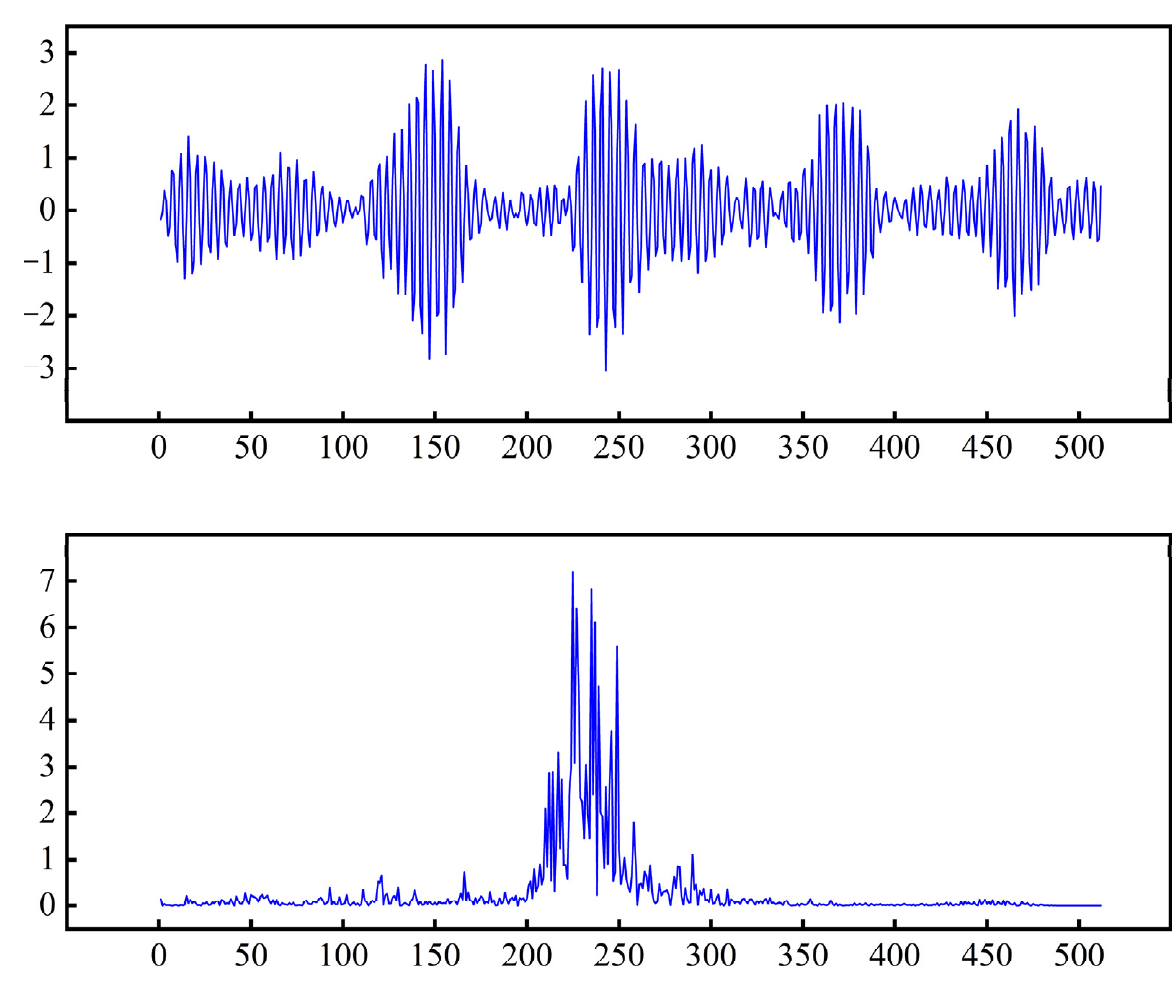
Figure 1. Vibration signal and its sparse coefficient.